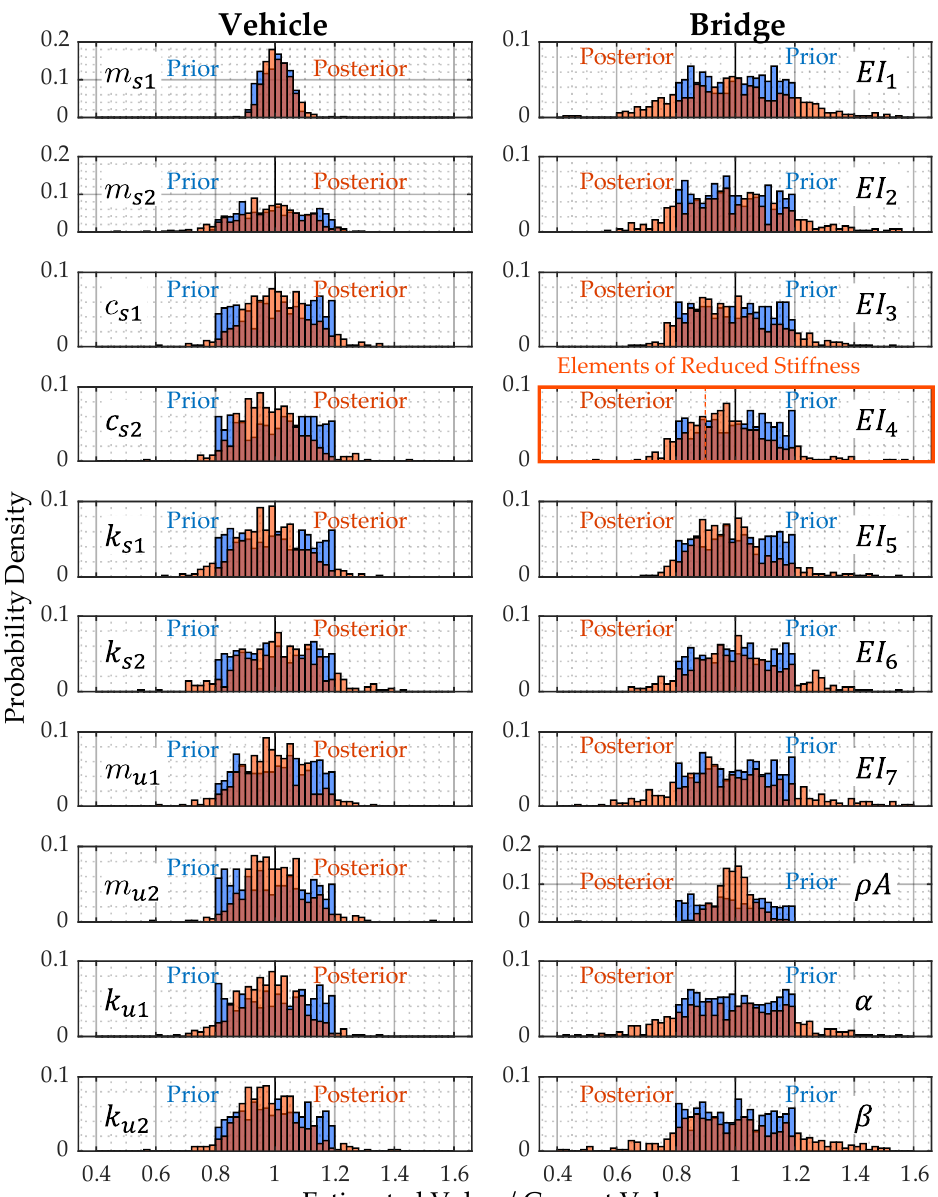
Figure A7. The application results of the PRE method in the case of Scenario 4 (stiffness decrease section: 3 L /7~4 L /7, decrease rate: 10%).